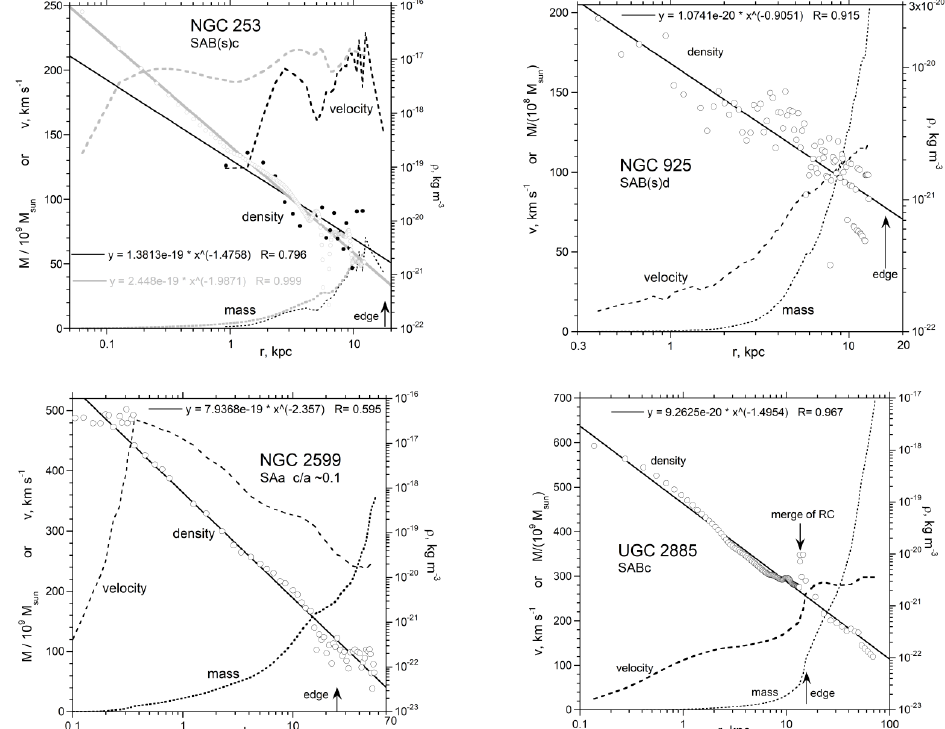
Figure A2. Large spirals: NGC 253 RCs from Sofue et al. [66] and derived M and ρ are colored grey. RCs from Hlavacek-Larrondo et al. [69] are black curves. Although velocity data differ substantially, similar mass and density are obtained near the visible edge. Differences at small r affect the fits to ρ ; NCG 925 has low velocities which produce low density; NGC 2599 RCs from Noordemeer et al. [61]. This spiral has both high v and a strong decline in v with radius. The increase in v at low r was assumed; UCG 2855 RCs below 13.7 kpc from Sofue et al. [66], and RCs above 13.7 kpc from Roelfsema and Allen [62]. The merge produces unrealistically high density over a short interval but does not seem to a ff ect the fit. A drop o ff in density exists at high r , whereas the trend is flatter than the fit near the galaxy